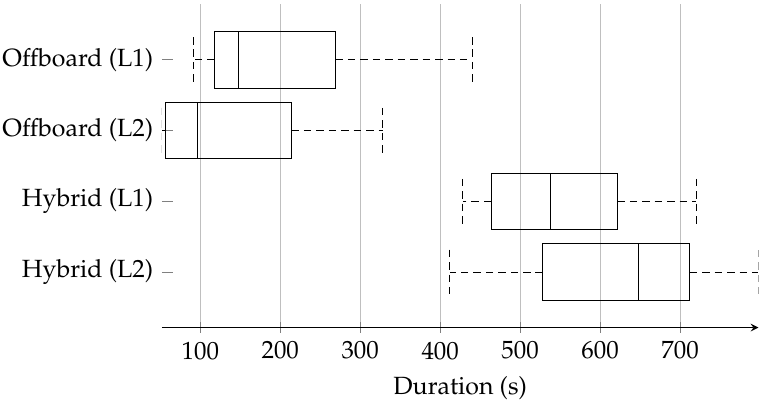
Figure 17. Distribution frequency of the elapsed time until the POMDP-based motion planner confirmed a detected victim in a trivial (L1) and complex (L2)